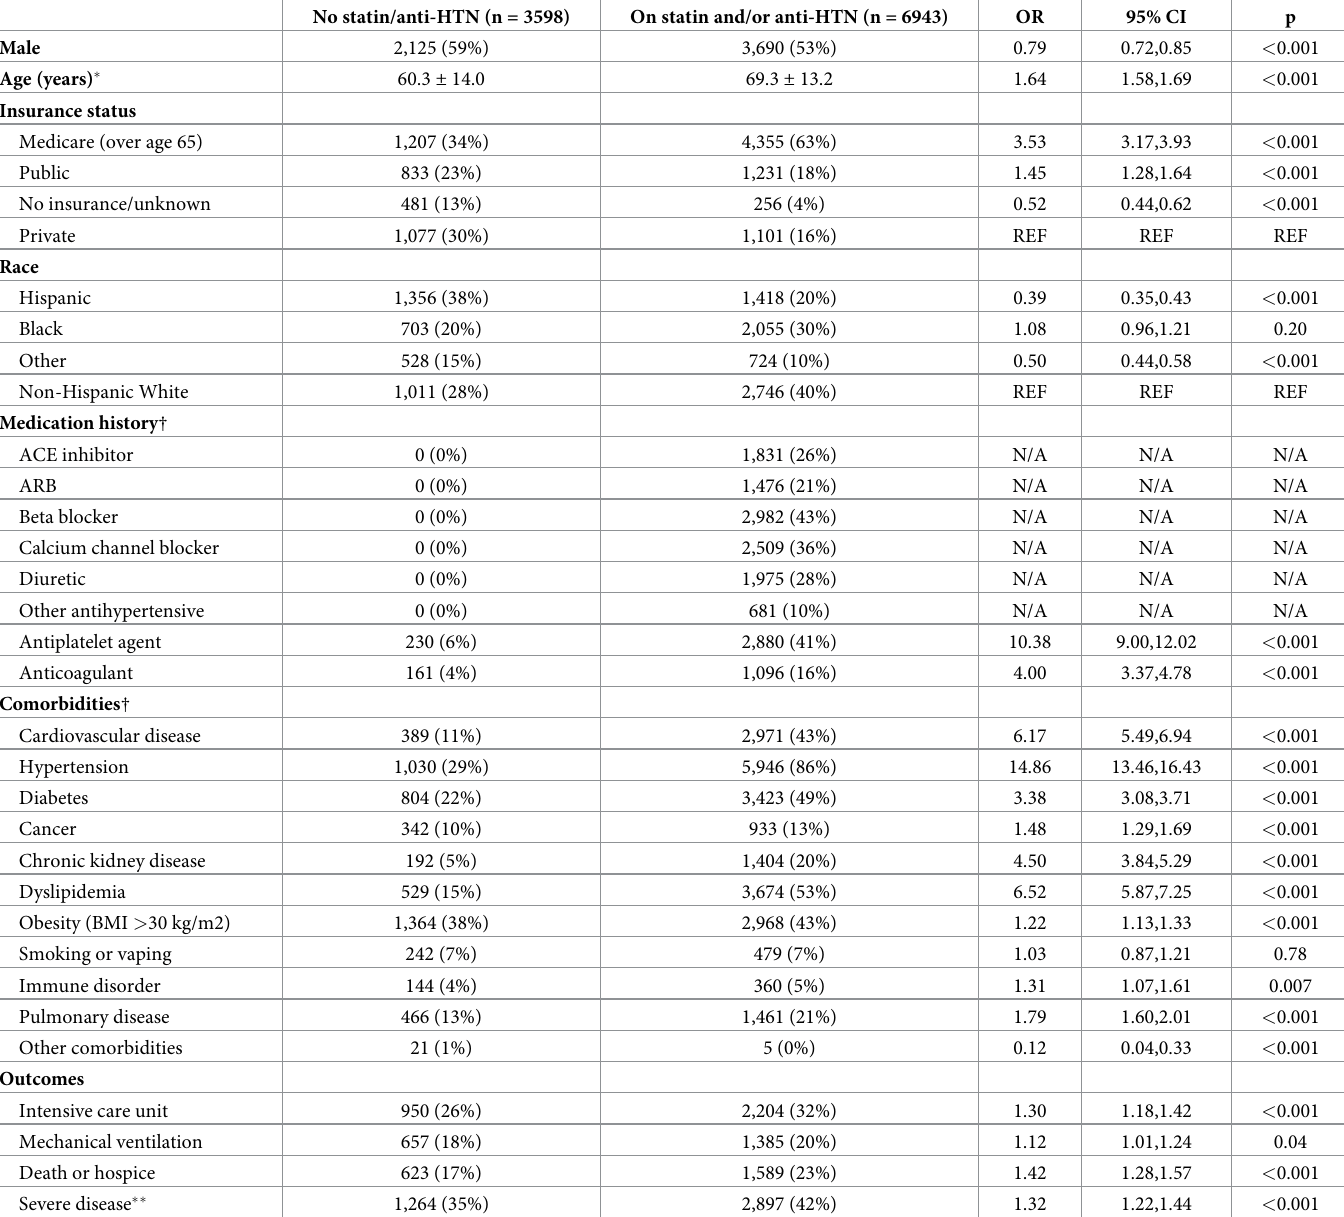
Table 1. Characteristics of patients on statin and/or anti-hypertensive medications compared to those on neither medication. No statin/anti-HTN (n = 3598) On statin and/or anti-HTN (n =